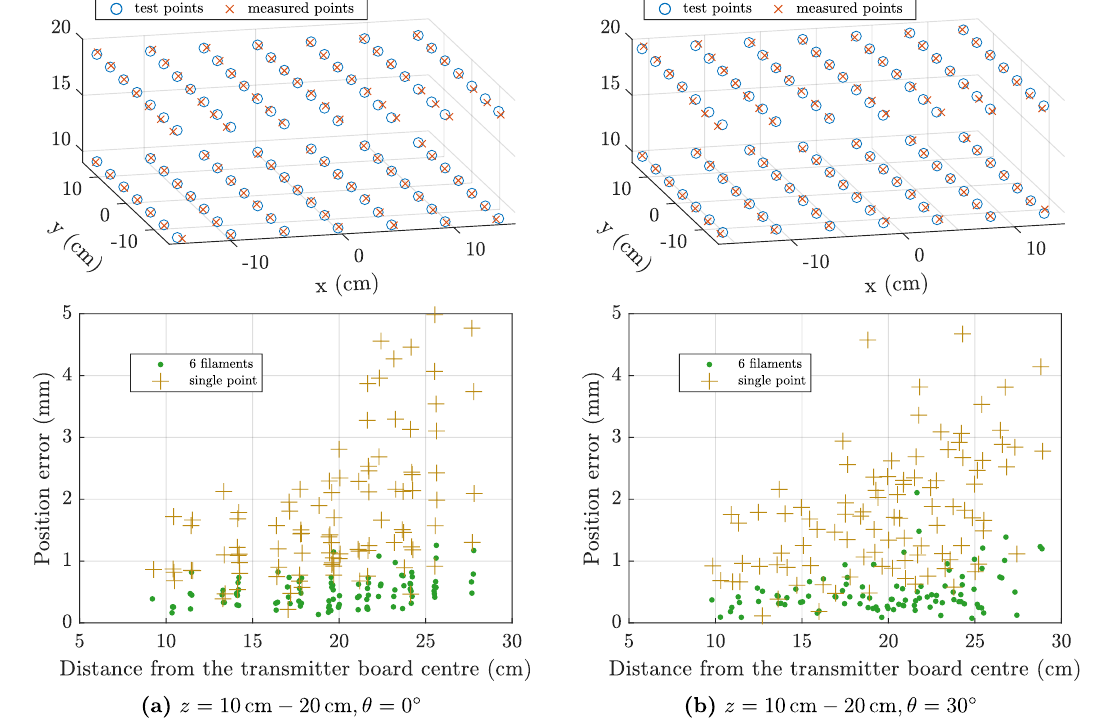
Figure 15. Static accuracy test with real data. In the first row, test points and positions solved using the single-point model. In the second row, scatter plot of the position error, for the 6-filament and single-point models. Columns ( a,b ) show the results for different sensor orientations, θ = 0 ◦ and θ = 30 ◦ , respectively.